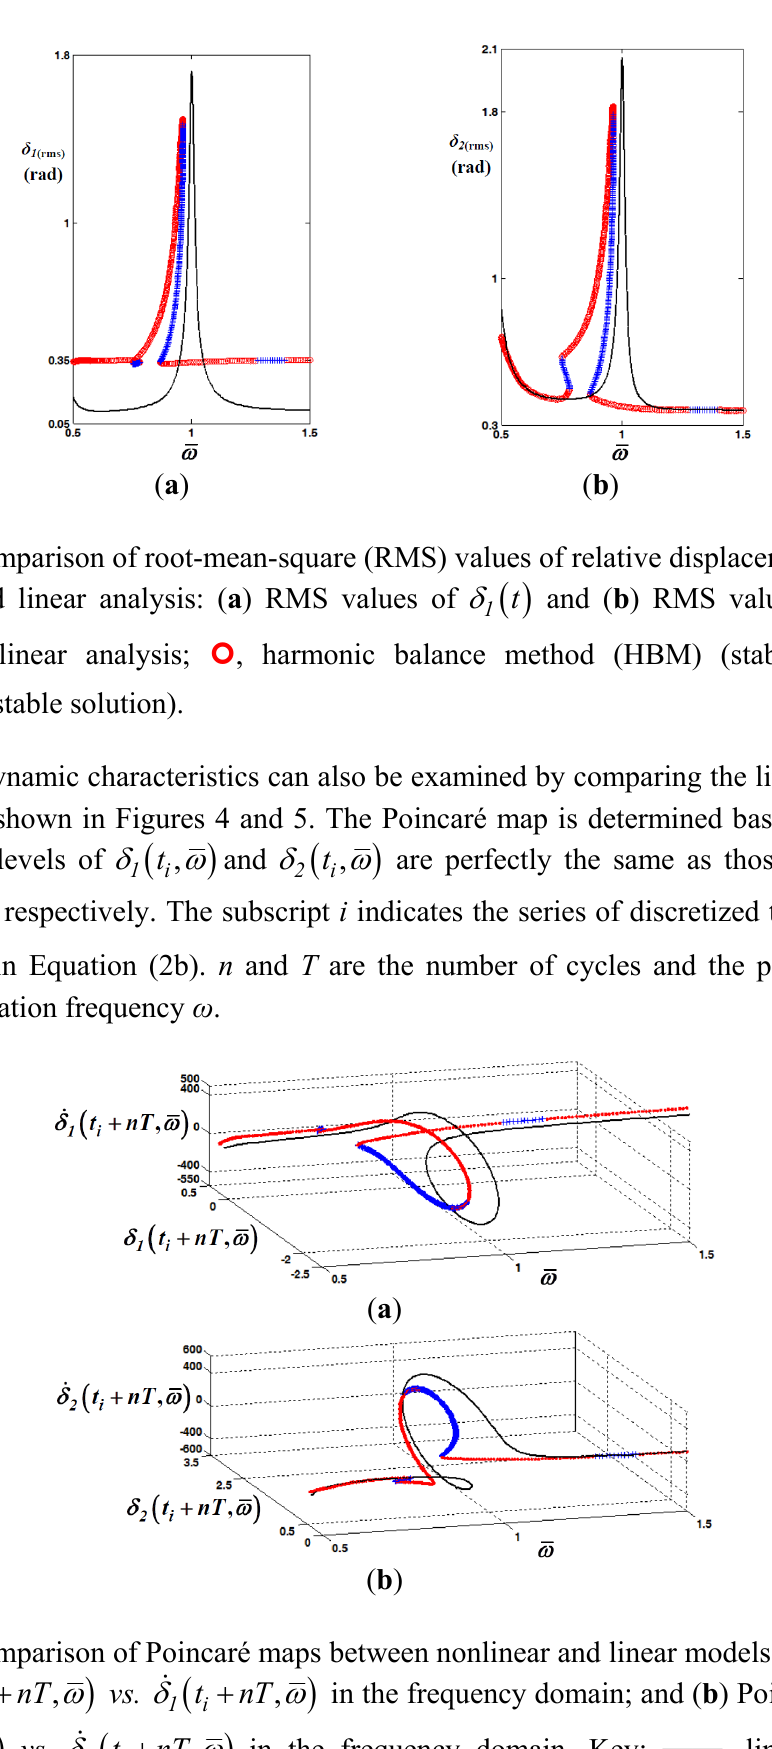
Figure 4. Comparison of Poincaré maps between nonlinear and linear models: ( a ) Poincaré t nT   vs.   , t nT    in the frequency domain; and ( b ) Poincaré map of map of   , 1 i 1 i   , t nT   vs.   , t nT    in the frequency domain. Key: ━━ , linear analysis; 2 i 2 i  , HBM (stable solution);  , HBM (unstable